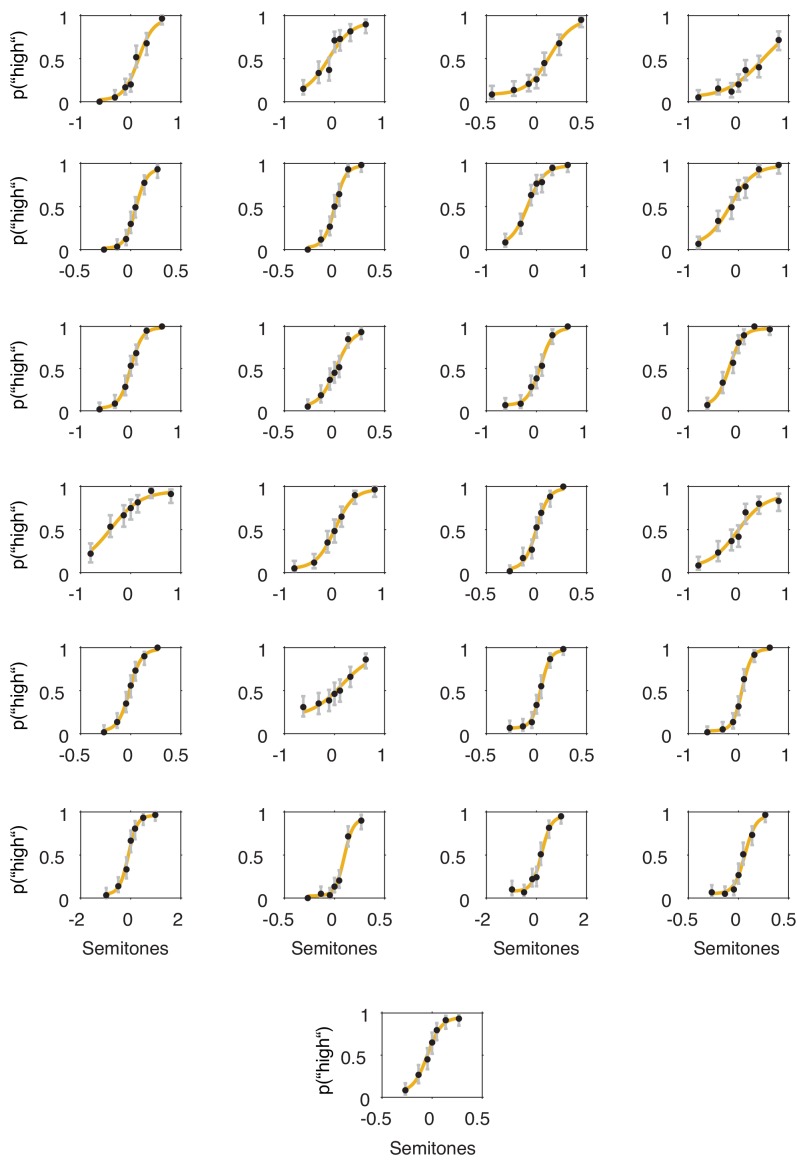
Single participant psychometric functions.